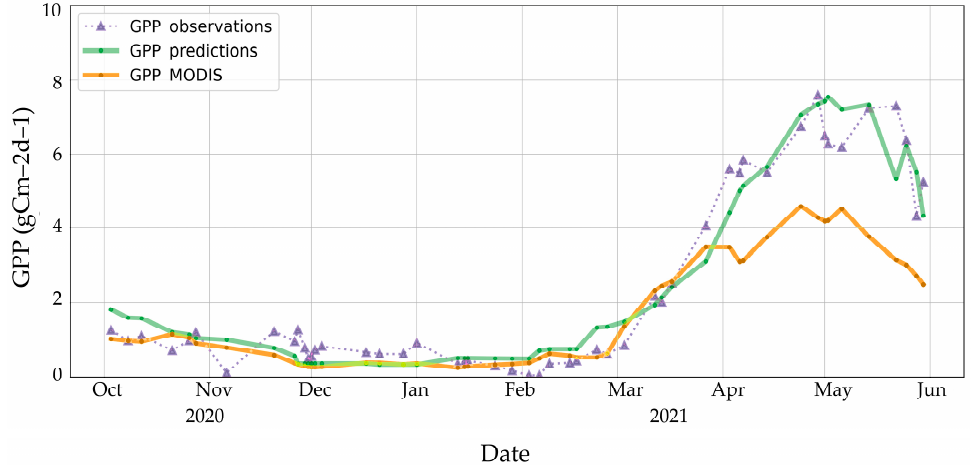
Figure 9. Time series of our model GPP predictions, MOD17 GPP prediction and in situ measurements of GPP.